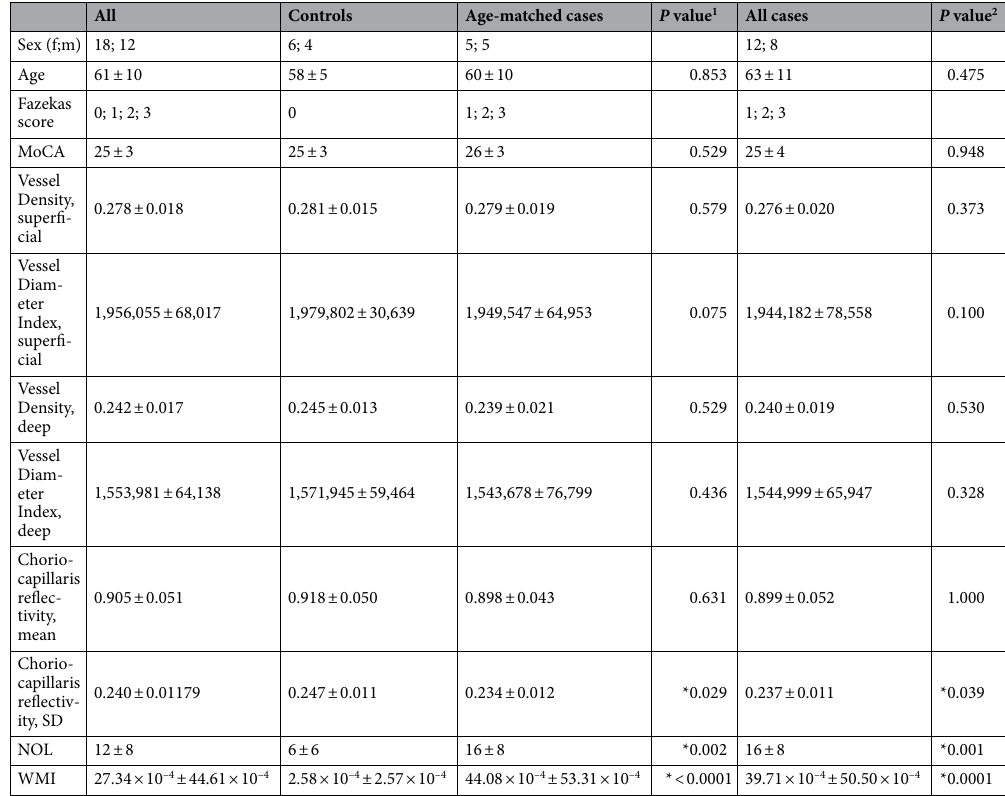
Table 1. Demographic MRI and OCT-A parameters for the overall sample and by CSVD cases and controls. MoCA, Montreal Cognitive Assessment; NOL, number of white matter hyperintensity lesions on magnet resonance imaging; WMI, White Matter Lesion Index; SD, standard deviation; 1 Comparison of age matched cases to controls, 2 Comparison of all cases to controls. The numbers are marked with asterisks to highlight statistical